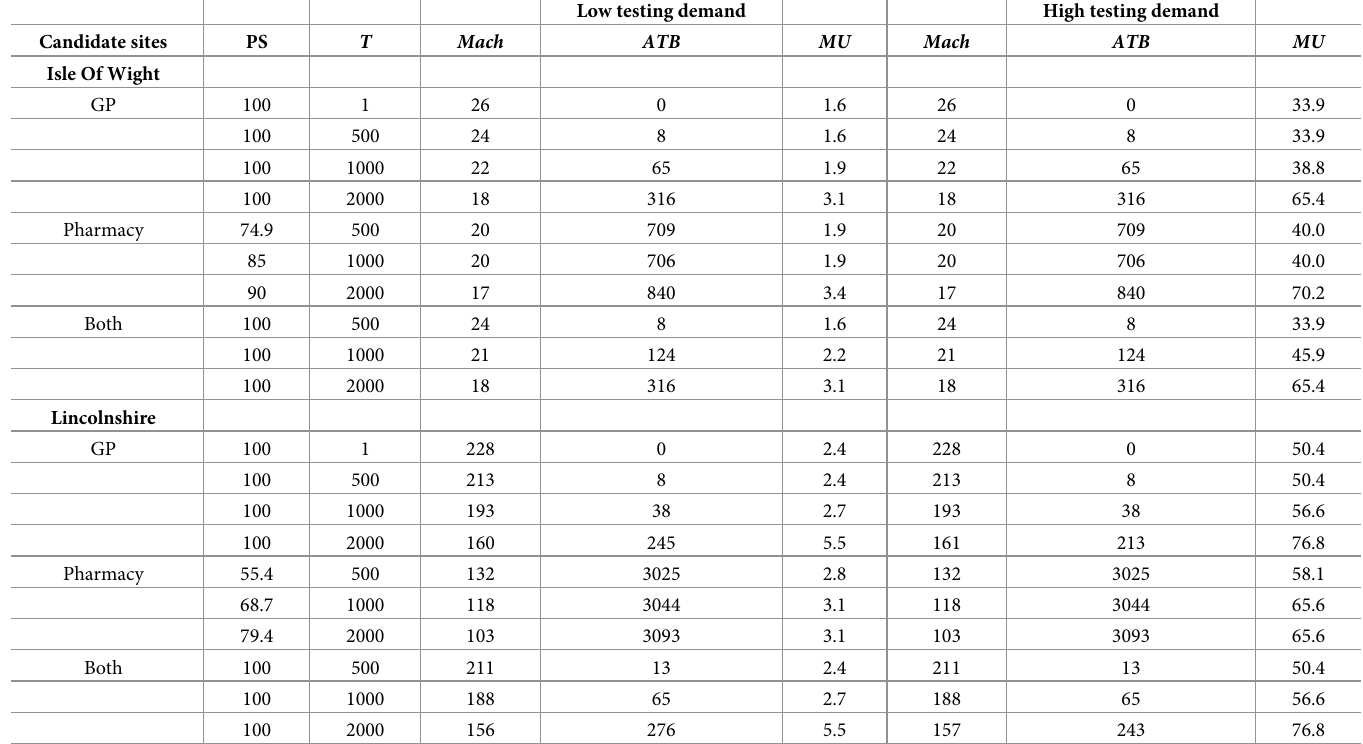
Table 4. Model results for urban areas. PS is the percentage of patients that can be served with the proposed maximum travel burden, T is the maximum travel burden allowed, Mach is the number of required testing machines, ATB is the average travel burden for the patients (m) and MU (%) is the highest capacity utilisation observed across all opened facilities, measured as the expected tests over the testing capacity of that